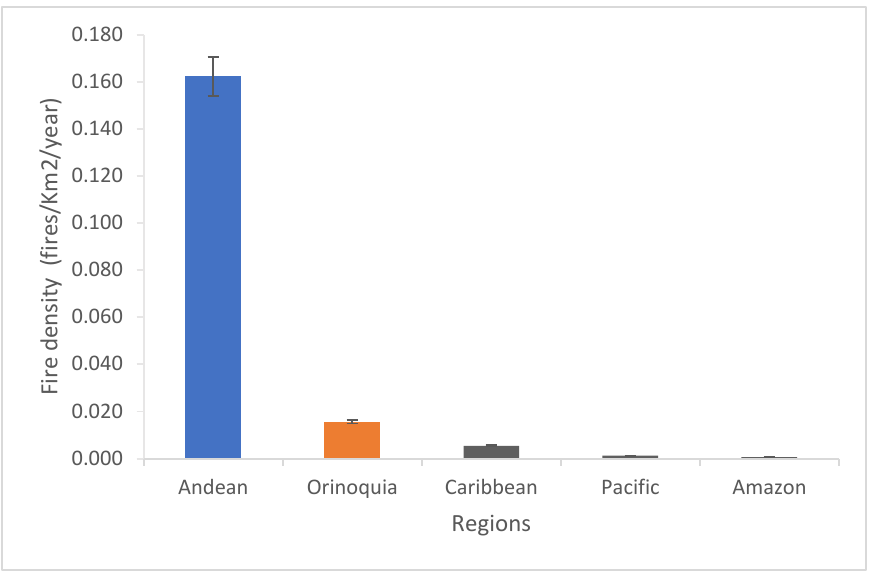
Figure 3. Average fire density per year in natural regions of Colombia over a 21-year period (2000 to 2020).